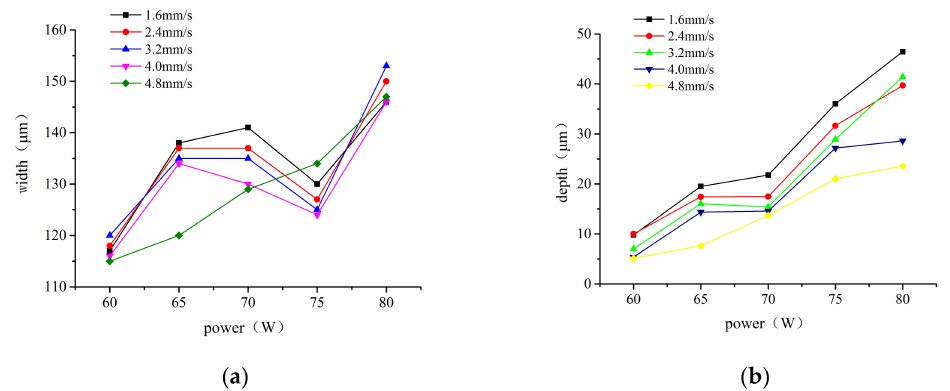
Figure 10. Microtexture geometry change with laser power and scanning speed: ( a ) width; ( b )